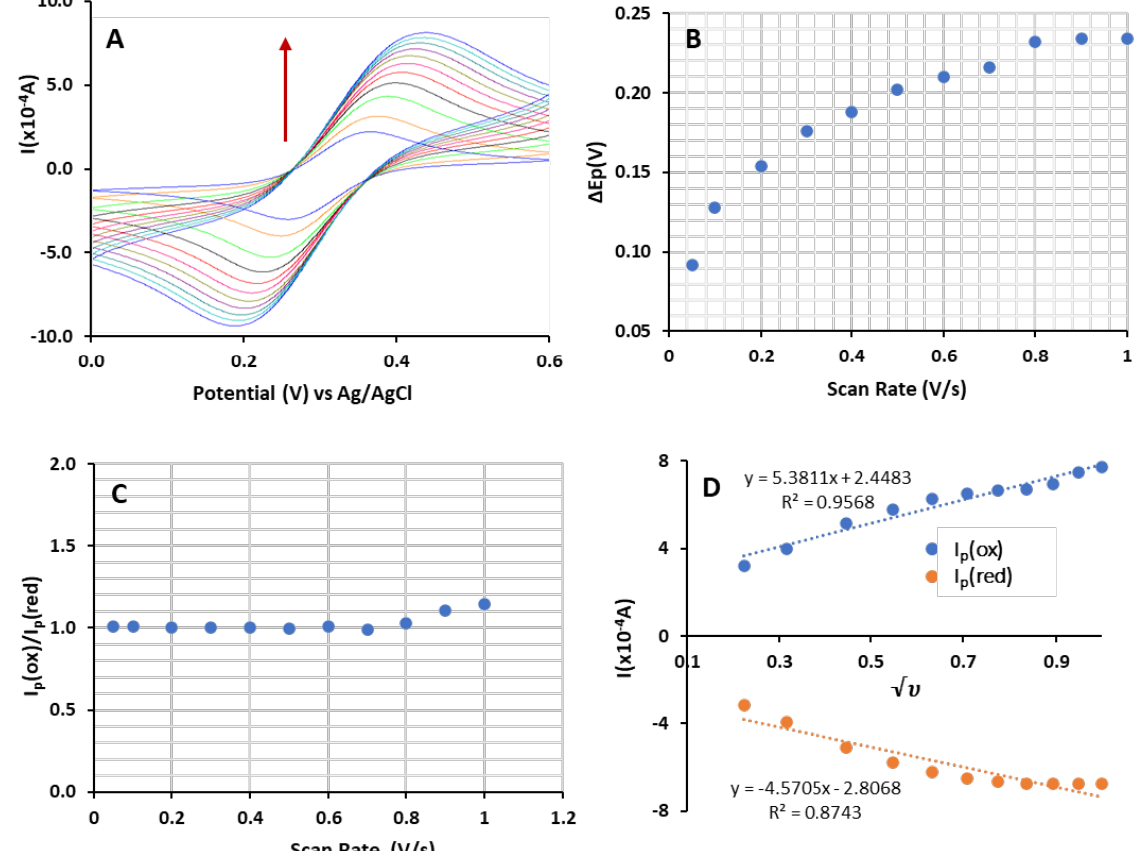
Figure 10. The influence of scan rate on the electrochemical response (CV) of the aptasensor using 5 mM [Fe(CN) 6 ] 3 − /4 − as a redox probe containing 0.5 M KCl as a supporting electrolyte. All experiments were carried out using a three-electrode setup with a gold electrode, a Pt wire, and Ag/AgCl electrode as the working electrode, the auxiliary electrode, and the reference electrode, respectively. CV experiments started at the open circuit potential (OCP) with positive initial scan polarity, sample interval of 2 mV, and with varying scan rate from 0.05 V/s to 1.0 V/s. ( A ) Cyclic voltammograms. Red arrow shows increase in the scan rate, ( B ) Graph of the peak potential separation (∆E p = E p (ox) − E p (red)) vs. scan rate, ( C ) Graph of I p (ox)/I p (red) vs. scan rate, ( D ) Graph of current vs. square root of scan rate for I p (ox) (blue curve) and I p (red) (orange curve).